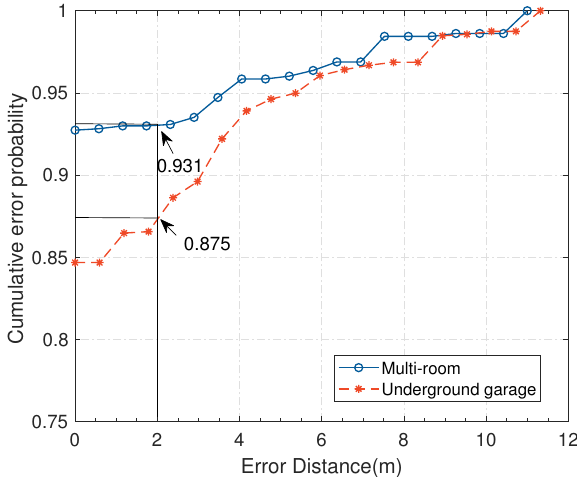
Figure 17. The Cumulative Distribution Function (CDF) of the error distance of C-InP in two